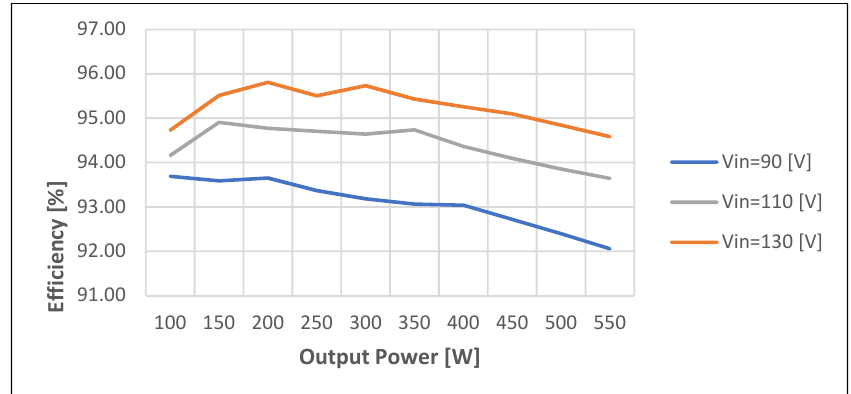
Figure 13. Laboratory practical efficiency measurements.